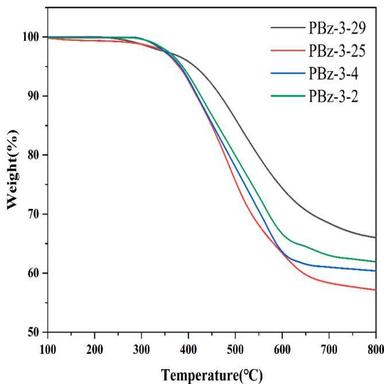
TGA curve of the four polybenzoxazines.